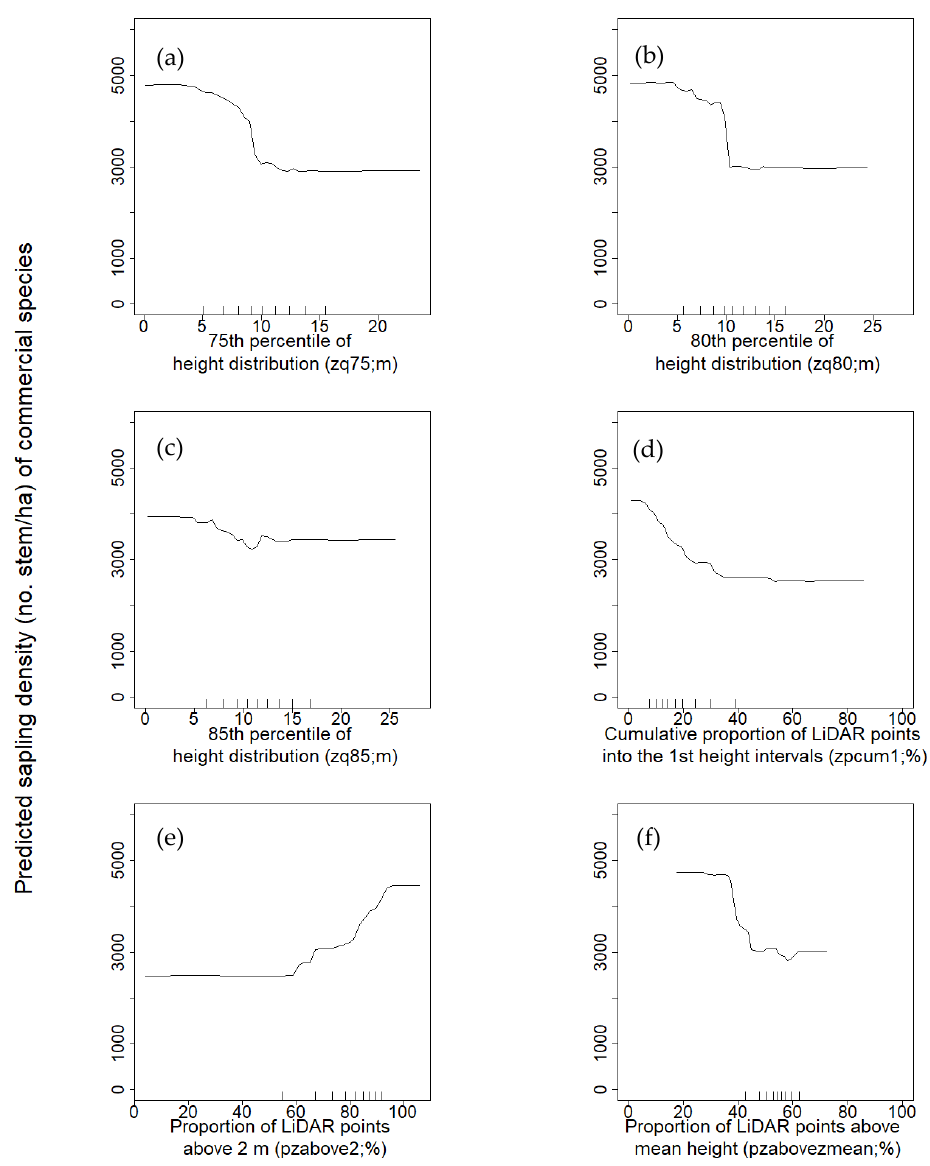
Figure 3. Partial dependence plots of ( a ) 75th (zq75), ( b ) 80th (zq80), and ( c ) 85th (zq85) percentiles of height distribution, ( d ) proportion of points in the first interval from ground (zpcum1), ( e ) proportion of LiDAR points above 2 m (pzabove2), and ( f ) proportion of LiDAR points above mean height (pzabovezmean; %) of random forest predictions of sapling density of commercial species (no. stem/ha) using both sensors.